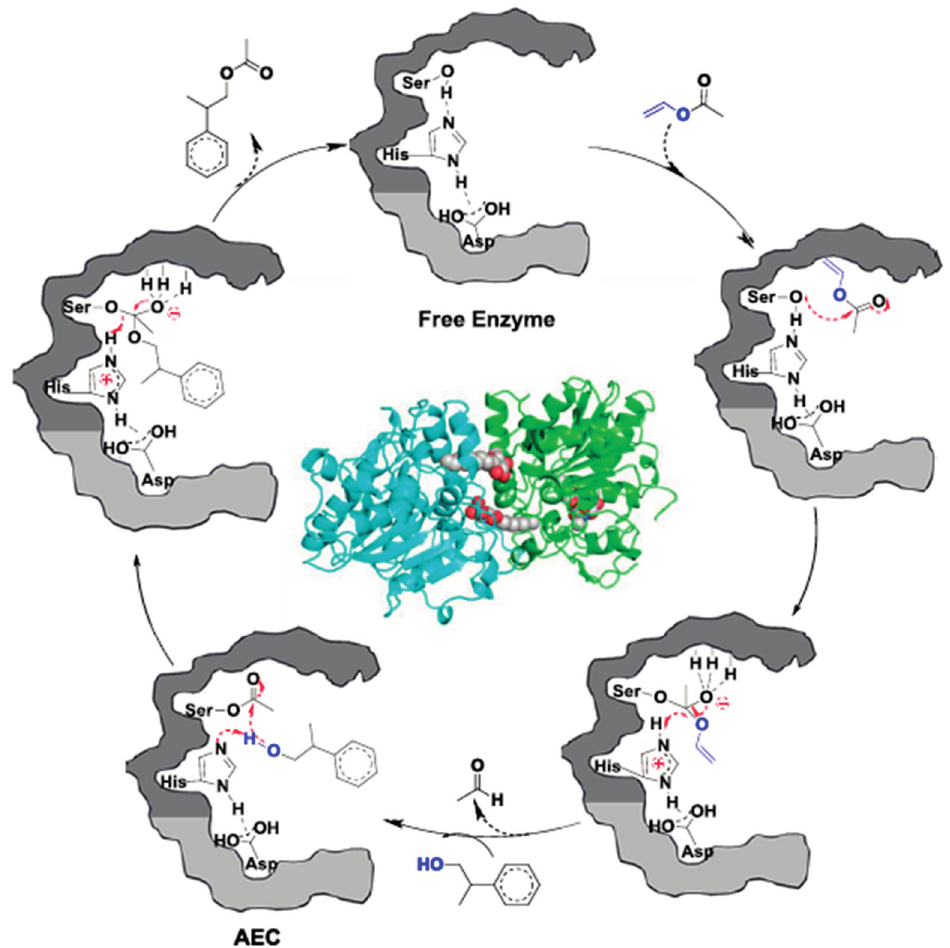
Figure 4. Illustration of the mechanism of CALB-catalyzed transesterification of vinyl acetate with 2-phenylpropane-1-ol. The different shading represents the two enzyme pockets